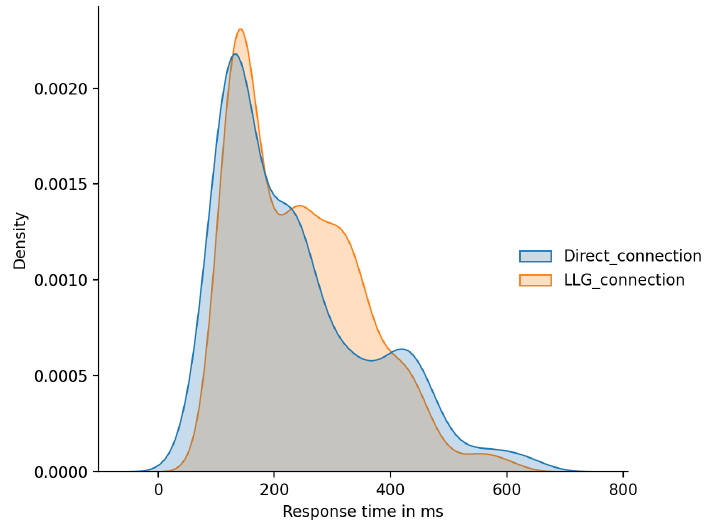
Figure 14. Direct_connection and LLG_connection distribution